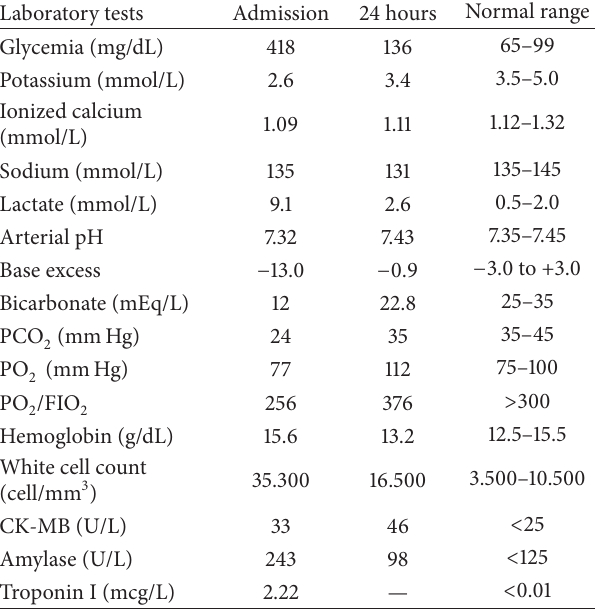
Table 1: Laboratory tests on admission and 24 hours